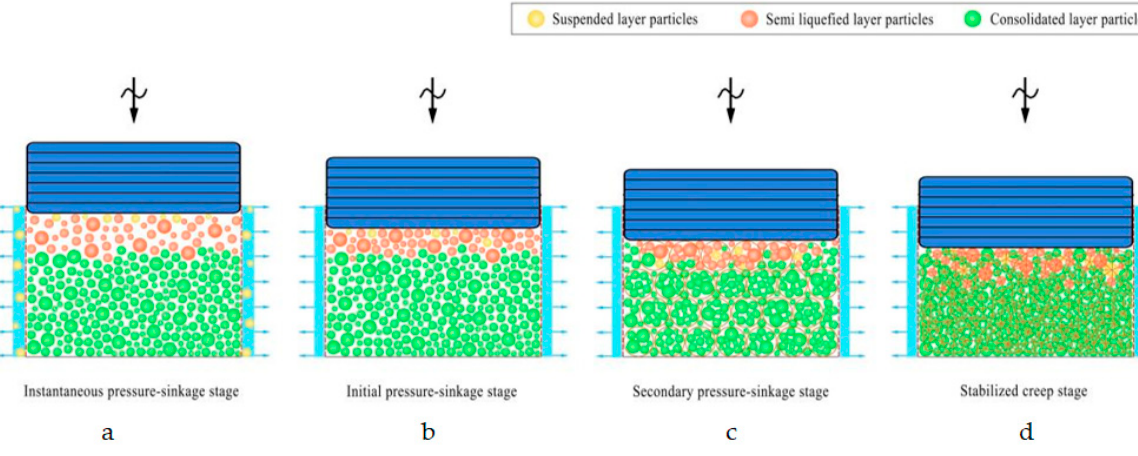
Figure 10. The changes involved in the micromechanism of deep-sea sediment compaction.